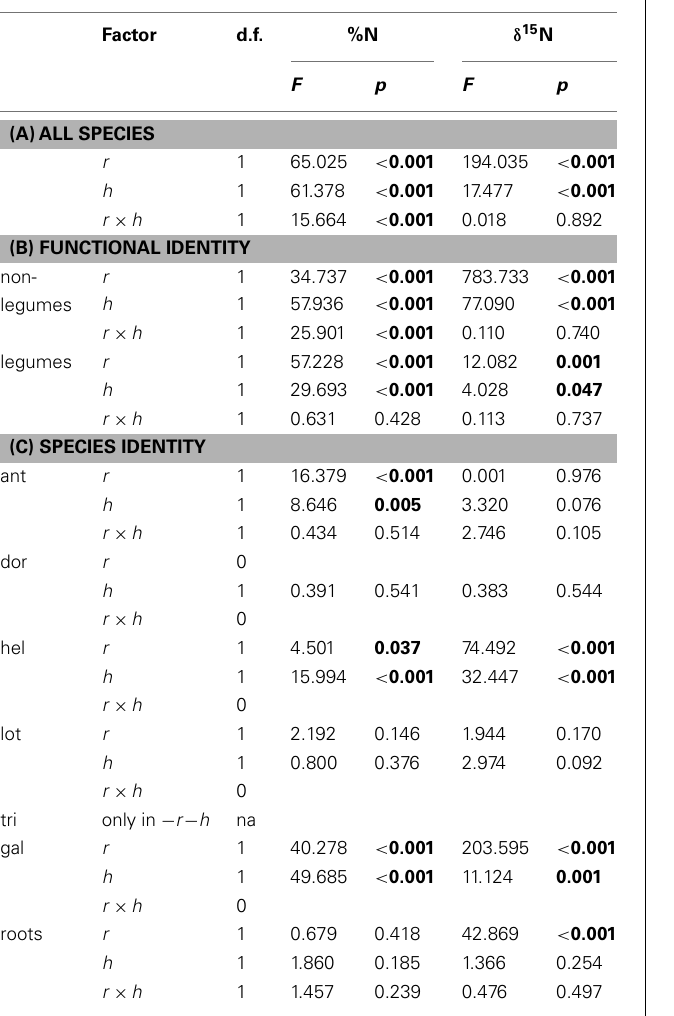
Table 3 |ANOVA results (Type III Sum of Squares) for effects of topsoil removal ( r ), hay transfer ( h ), and their interaction effect ( r × h ) on N concentration and δ 15 N in plant leaves.